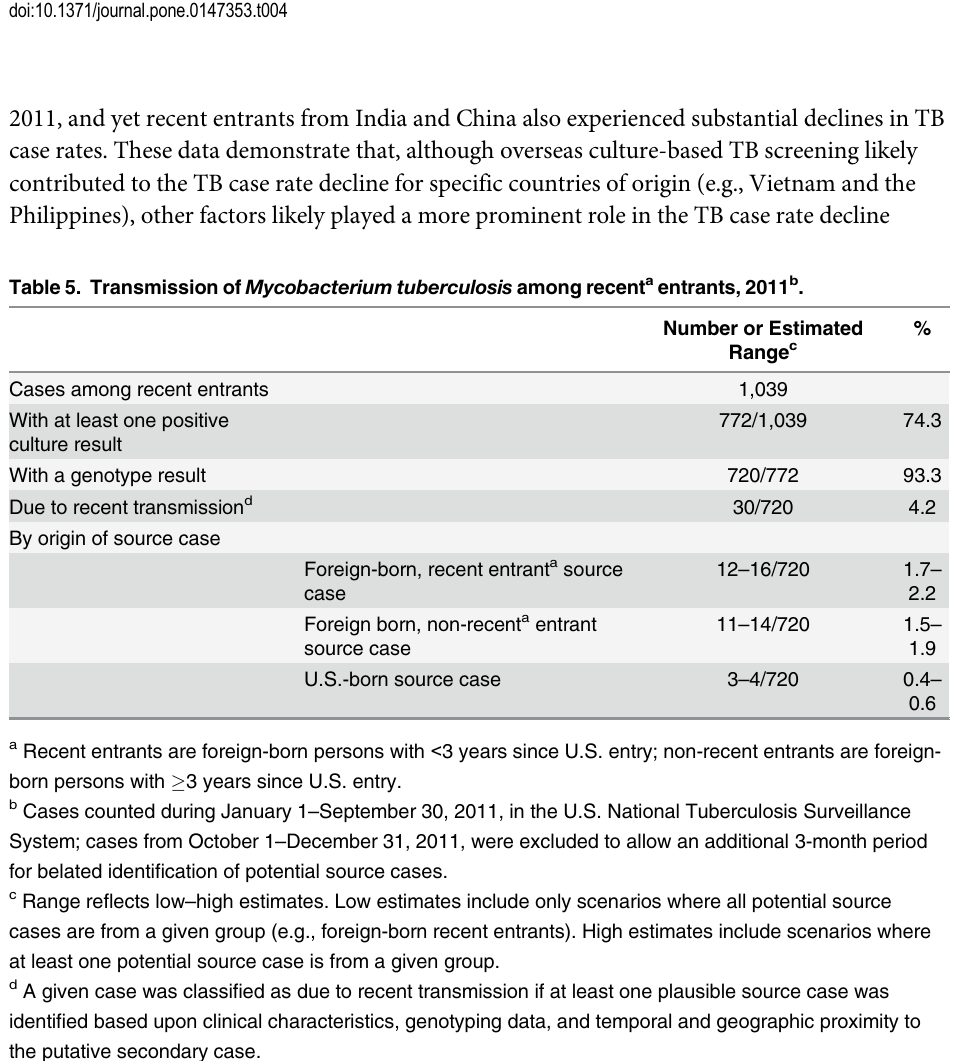
a The fi ve countries of origin accounting for the greatest number of tuberculosis cases among foreign-born persons in the United States. b